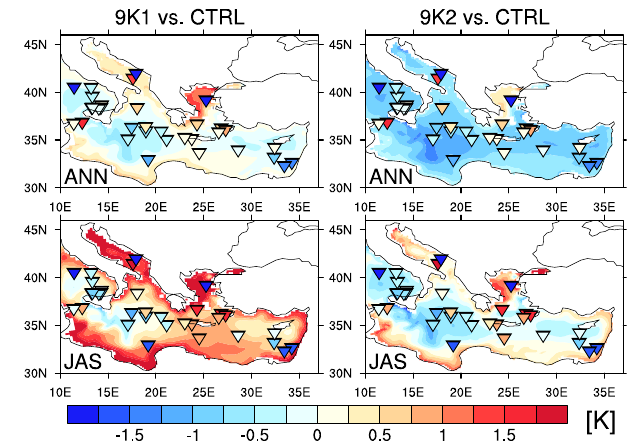
Fig. 21. Annual and summer (JAS) T 0 − 30 anomalies, calculated from SST reconstructions from proxy data (triangles, Kucera et al. (2011)) vs. modelled one (background colour) for 9K1 vs. CTRL (left) and 9K2 vs. CTRL (right). 1st row displays annual T 0 − 30 anomalies, 2nd row displays summer T 0 − 30